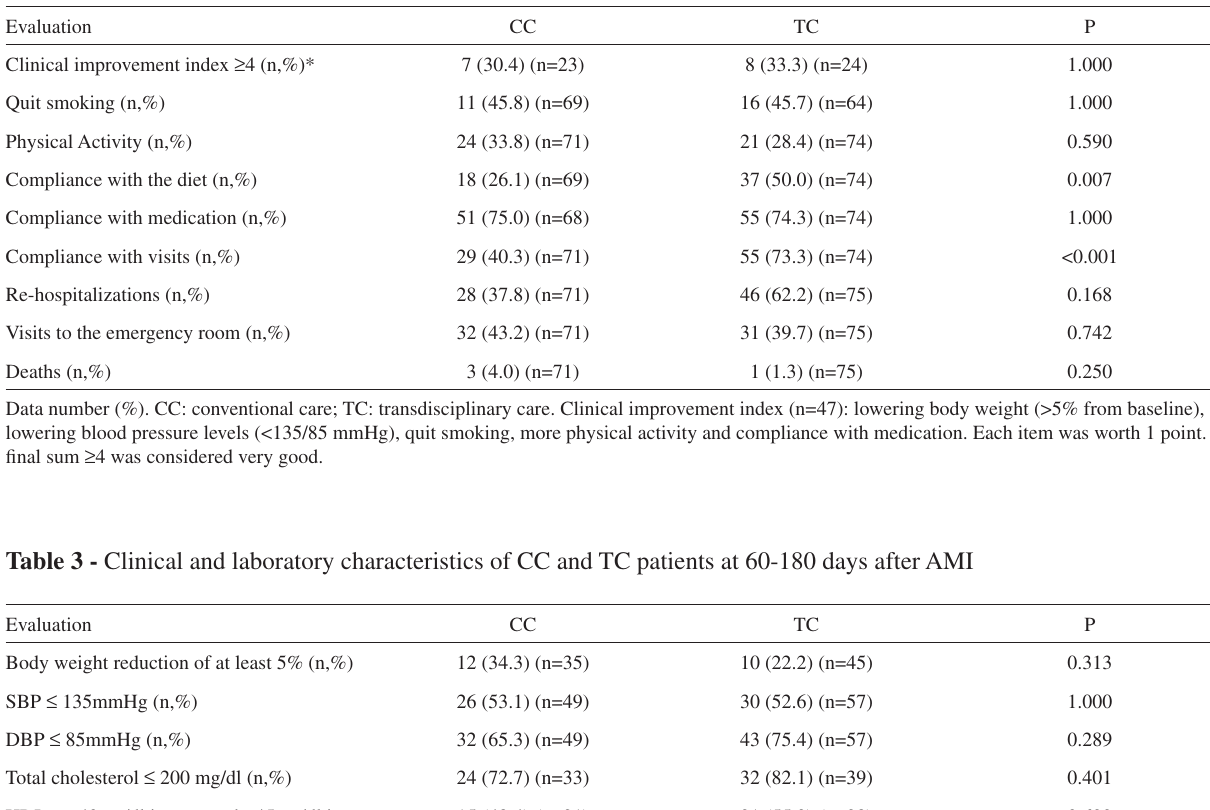
Table 2 - Clinical outcomes and compliance: Comparative analysis at 60-180 days after AMI of the evolution of patients receiving CC and TC